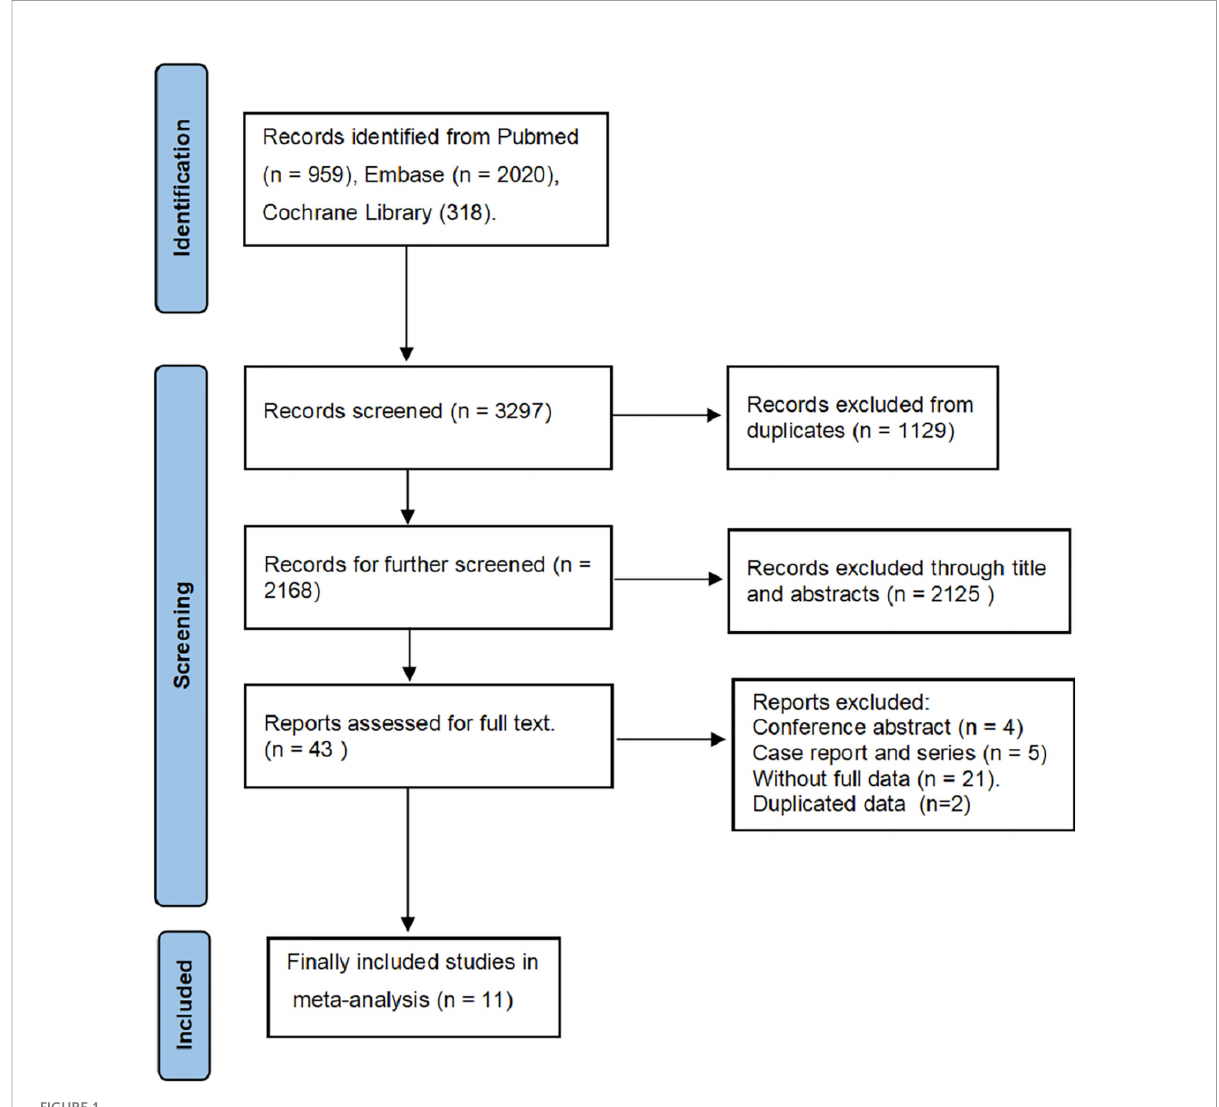
FIGURE 1 Flow diagram of the selection process of relevant